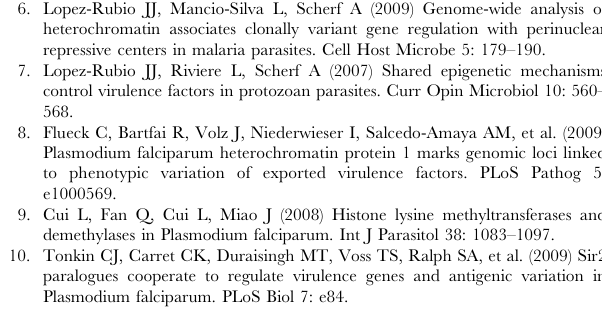
Figure S4 var gene family transcription profile for C3 cultures from Figure 4 also shown as bar graphs. The dominant var gene in